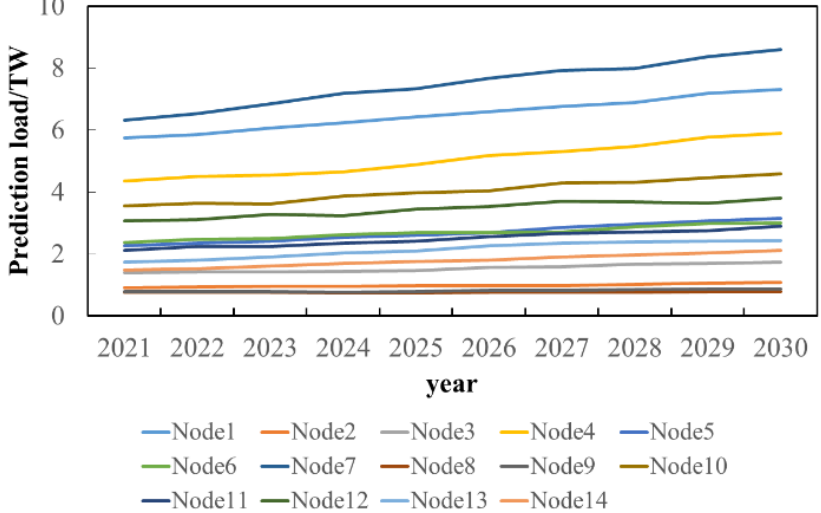
Figure 14. Load prediction results of each node.